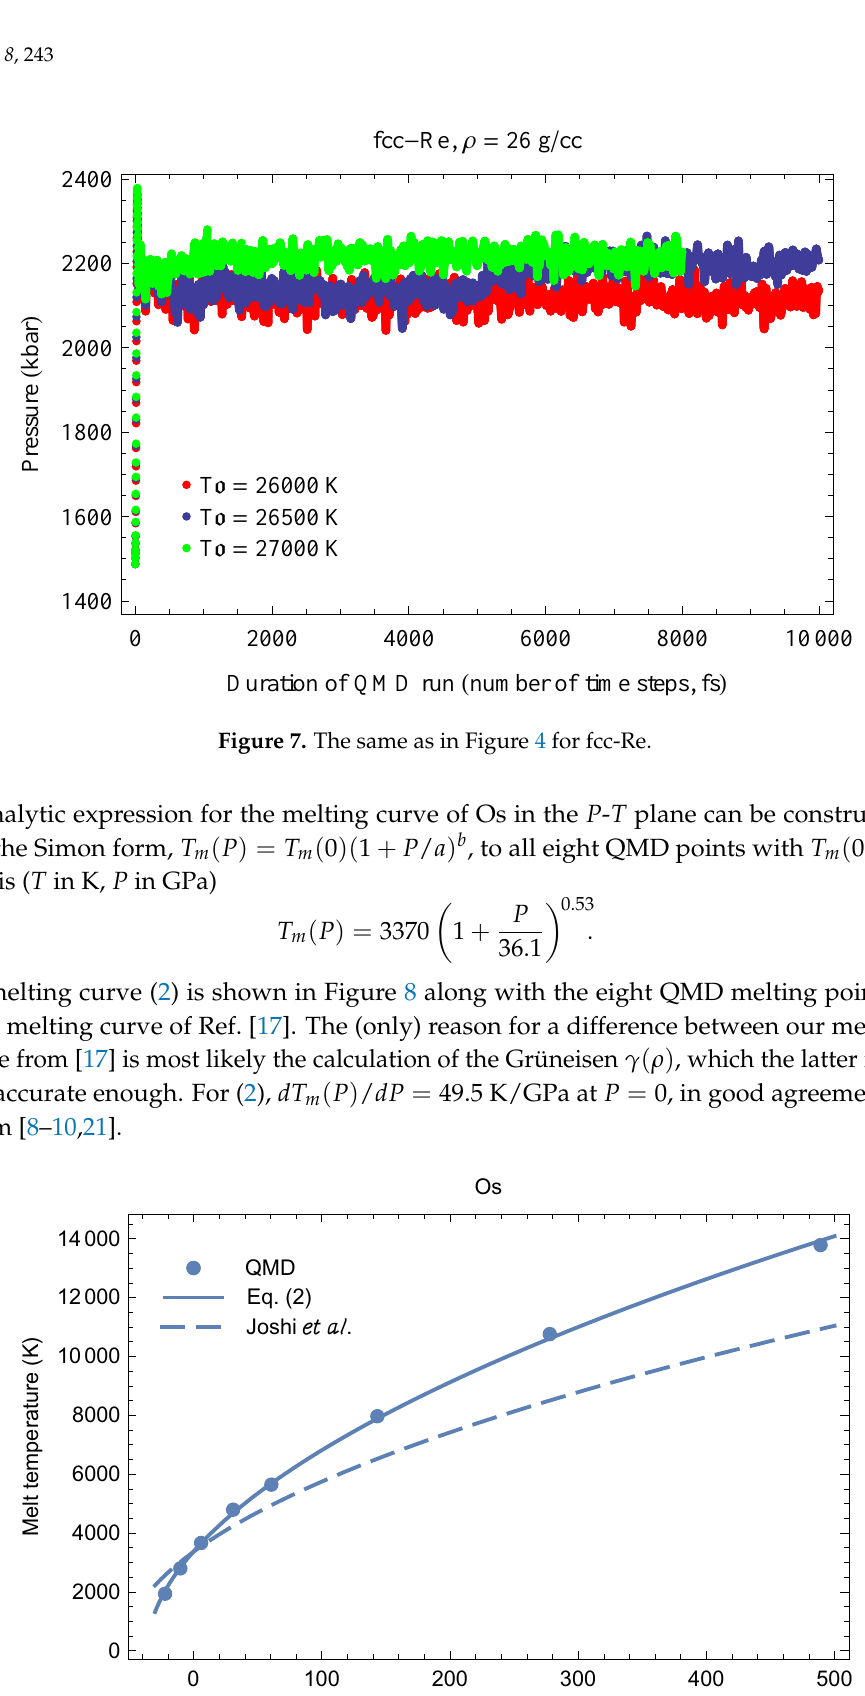
Figure 11. The phase diagram of Re based on the theoretical results of this work vs. the experimental DAC data of Ref. [6].